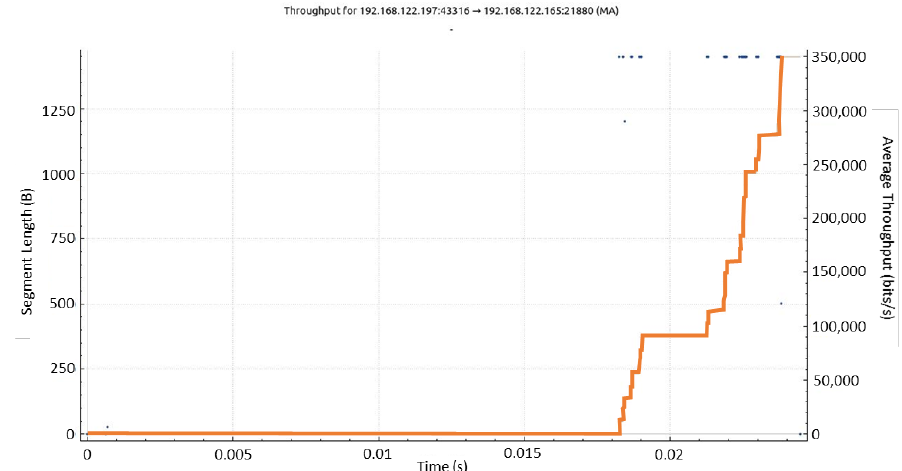
Figure 9. Encrypted file throughput.